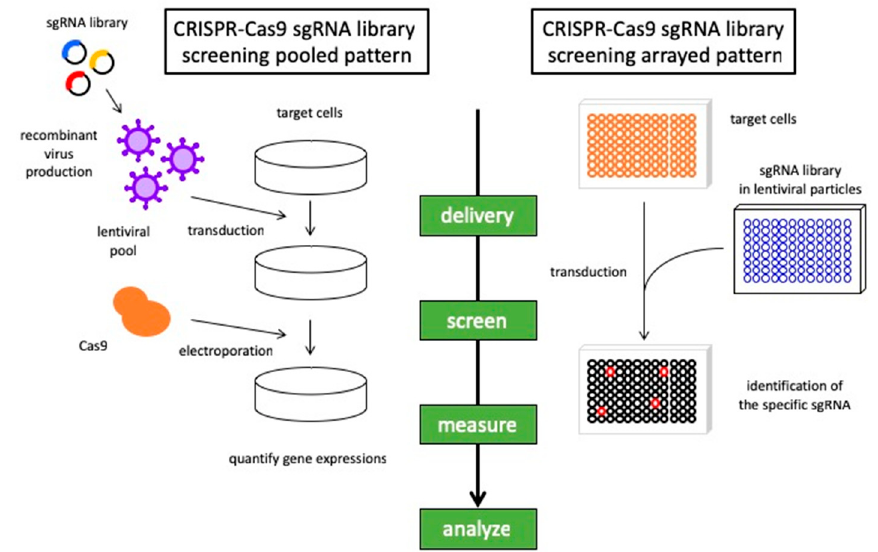
Figure 2. Synthetic lethality screening with CRISPR libraries. The general workflow for synthetic lethality screening using the CRISPR-Cas9 system in pooled and arrayed assay methods. In a pooled pattern, transducted cells are subjected to the next-generation sequencer to provide the enrichment of gene expression by the selection of sgRNA. In an arrayed pattern, cells are transducted by lentivirus containing sgRNA libraries and the phenotypes were evaluated corresponding to the sgRNA. The basic principle is common, and it is desirable to choose the method according to the situation.